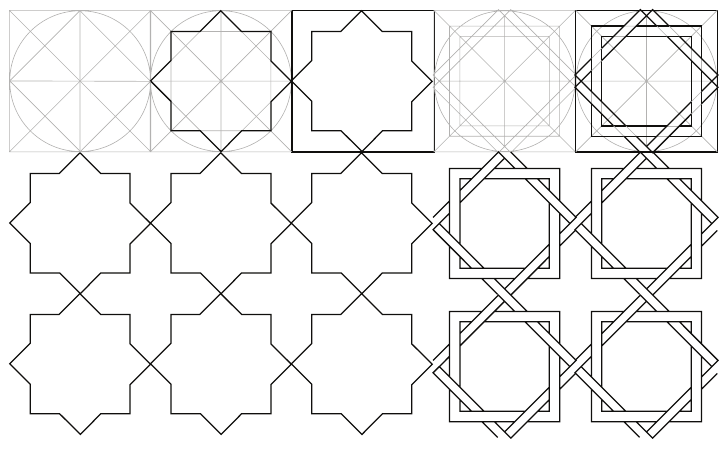
Figure 3: Islamic